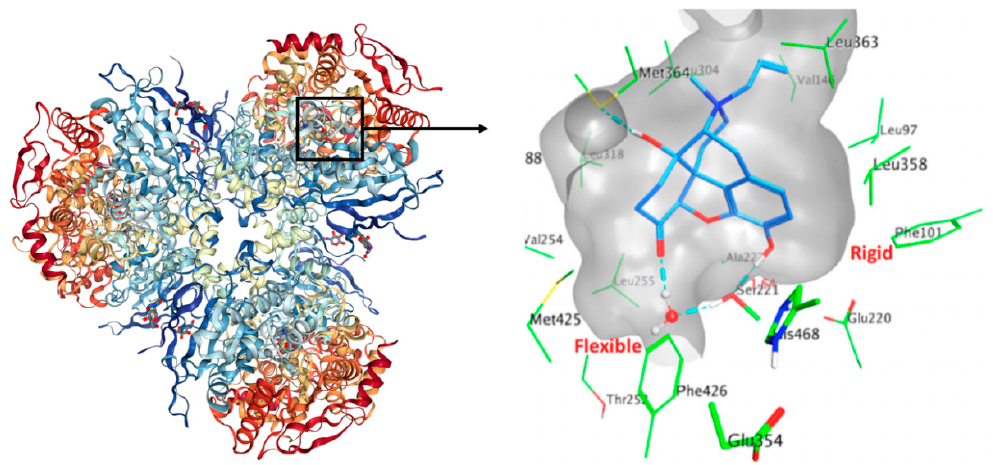
Figure 1. The figure on the left side represents the X-ray of CES1 complexed with naloxone (PDBID: 1mx9). The figure on the right side is a zoom on the binding site of CES1 where naloxone is located. The protein is represented as a grey transparent surface. Residue side chains within 4.5 Å of the ligand are shown as green sticks. Hydrophobic interactions are predominant. Intermolecular hydrogen bonds are shown as cyan dashes. The catalytic triad residues Ser221–Glu354–His468 located at the base of the active gorge and between the rigid and flexible pockets are shown in thick sticks. The average distance between Ser221 side chain and naloxone’s hydroxyl group is indicated with a solid red line.